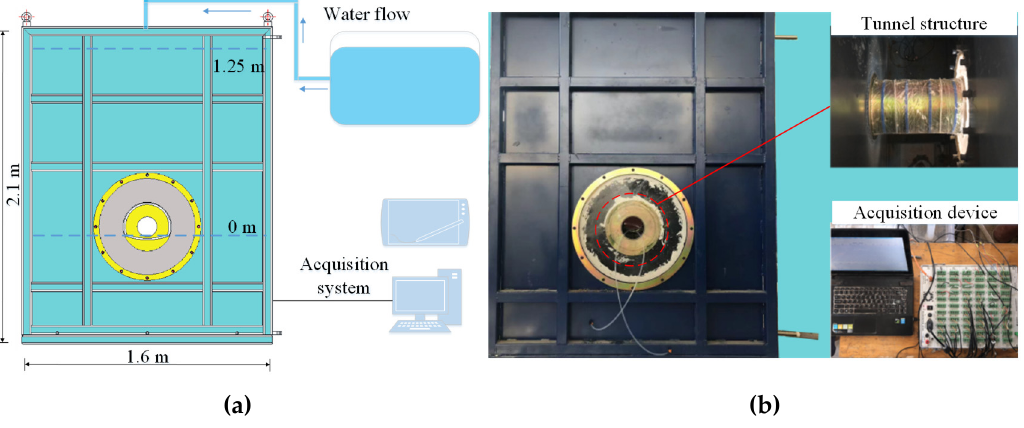
Figure 4. Model test system: ( a ) design sketch; ( b ) test photo.